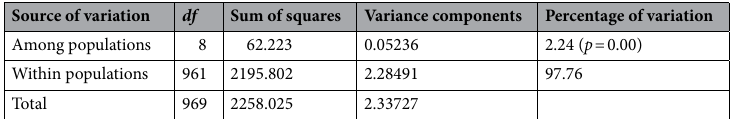
Table 2. Outcomes of AMOVA analysis based on the variability of 10 autosomal loci for 9 analyzed populations.